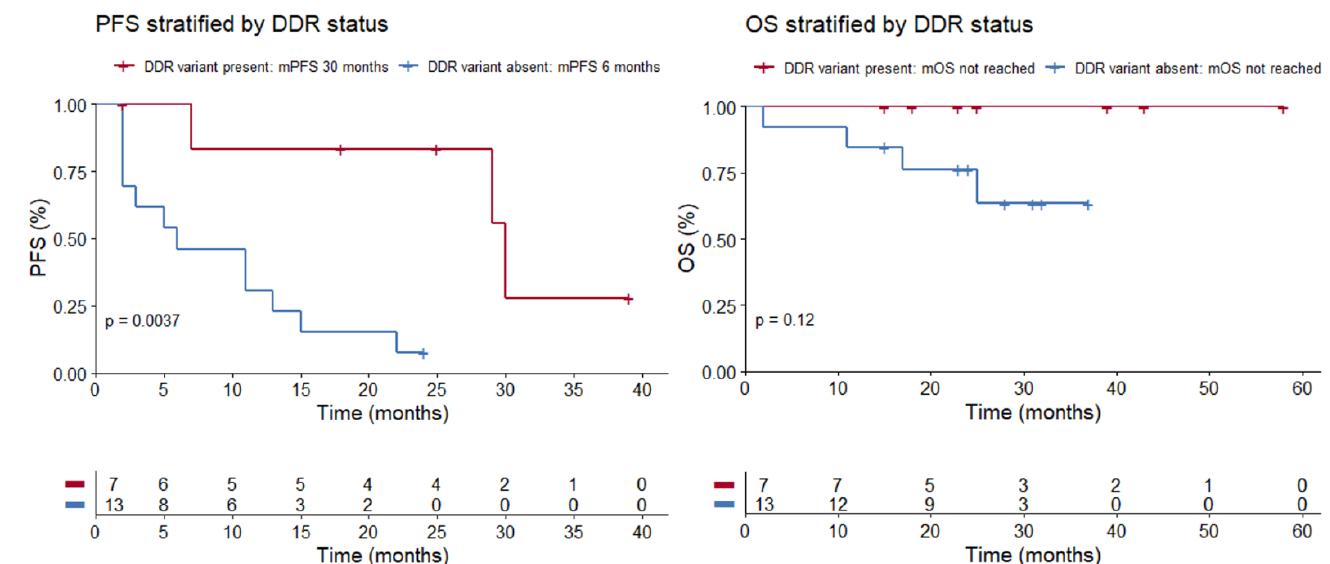
Curr. Oncol. 2021 , 28, Figure 1. mPFS was 30 months in the patient group where a germline DDR variant was present, compared to 6 months in the patient group where a germline variant was absent ( p = 0.0037, log-rank test). mOS was not reached, both in the patient group where a germline DDR variant was present and where it was absent ( p = 0.12, log-rank test). Abbreviations: PFS = progression free survival, DDR = DNA damage response, mPFS = median progression free survival, OS = overall survival, mOS = median overall survival.